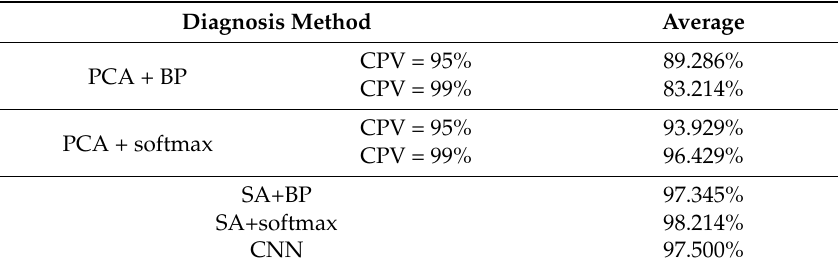
Table 6. Experimental results based on different